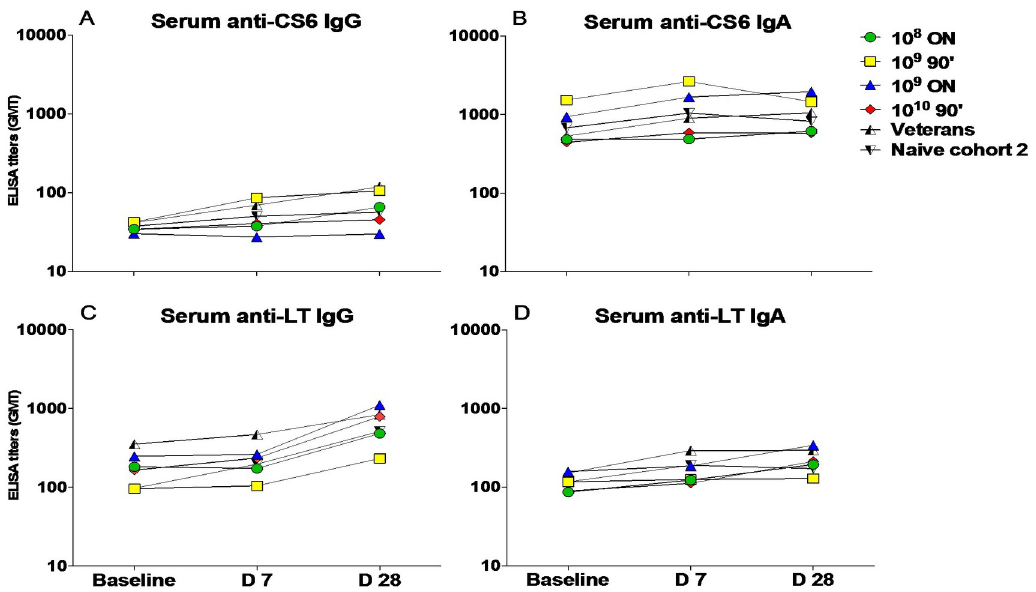
Fig 4. Serum IgG and IgA responses to CS6 and LT as measured by ELISA after B7A challenge. (A) IgG anti-CS6; (B) IgA anti-CS6; (C) IgG anti-LT; (D) IgA anti-LT. IgG and IgA antigen-specific responses were evaluated by ELISA before the oral challenge (baseline), and at 7 and 28 days later. Graphs represent GMT per time point per group. Cohort 1 groups divided by dose and fasting times. (ON- overnight, 90’- 90 minute). Cohort 2 divided into veterans and na ï ve.